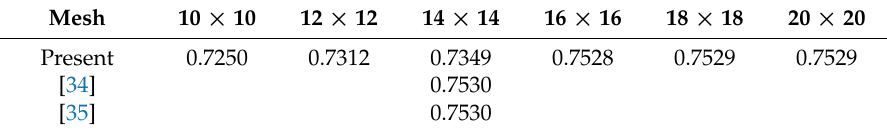
Table 1. Maximum deflections w c versus mesh density ( a / h = 10).